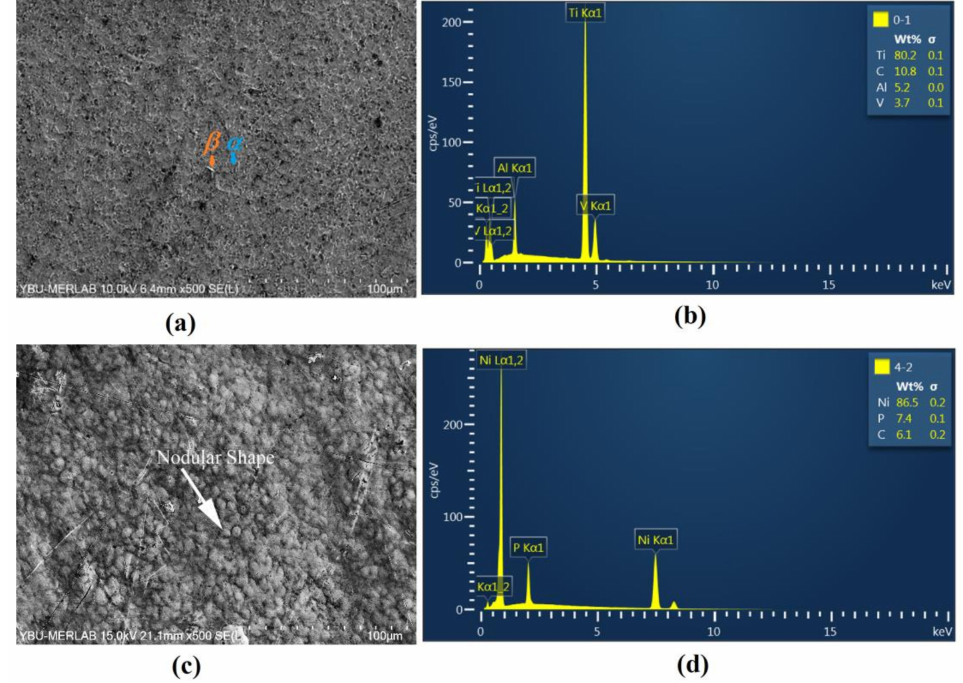
Figure 3. Surface morphologies and SEM, EDS images of the substrates ( a ) SEM image of Ti-6Al-4V; ( b ) EDS image of Ti-6Al-4V; ( c ) SEM image of Ni-P-Gr; ( d ) EDS image of